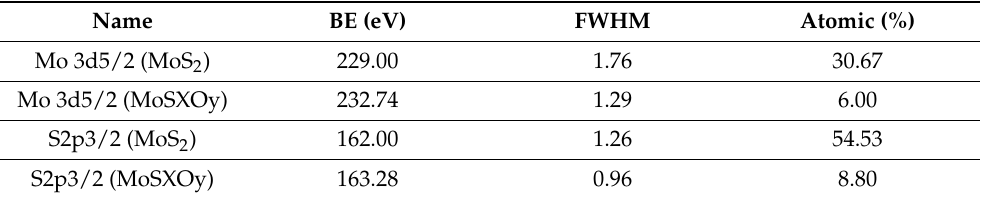
Table 1. Ratio of molybdenum (Mo) and sulfide (S) in different valence states in photoelectron spectroscopy (XPS) spectral